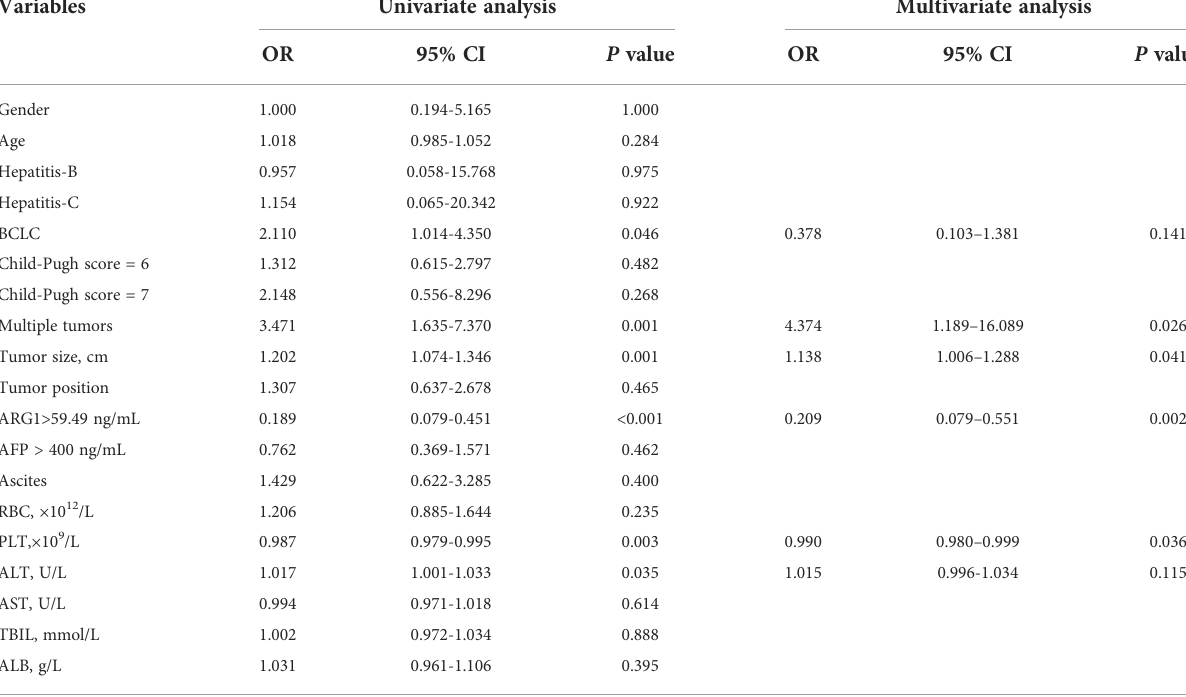
TABLE 2 Univariate and multivariate analyses for predictive factors of early TACE